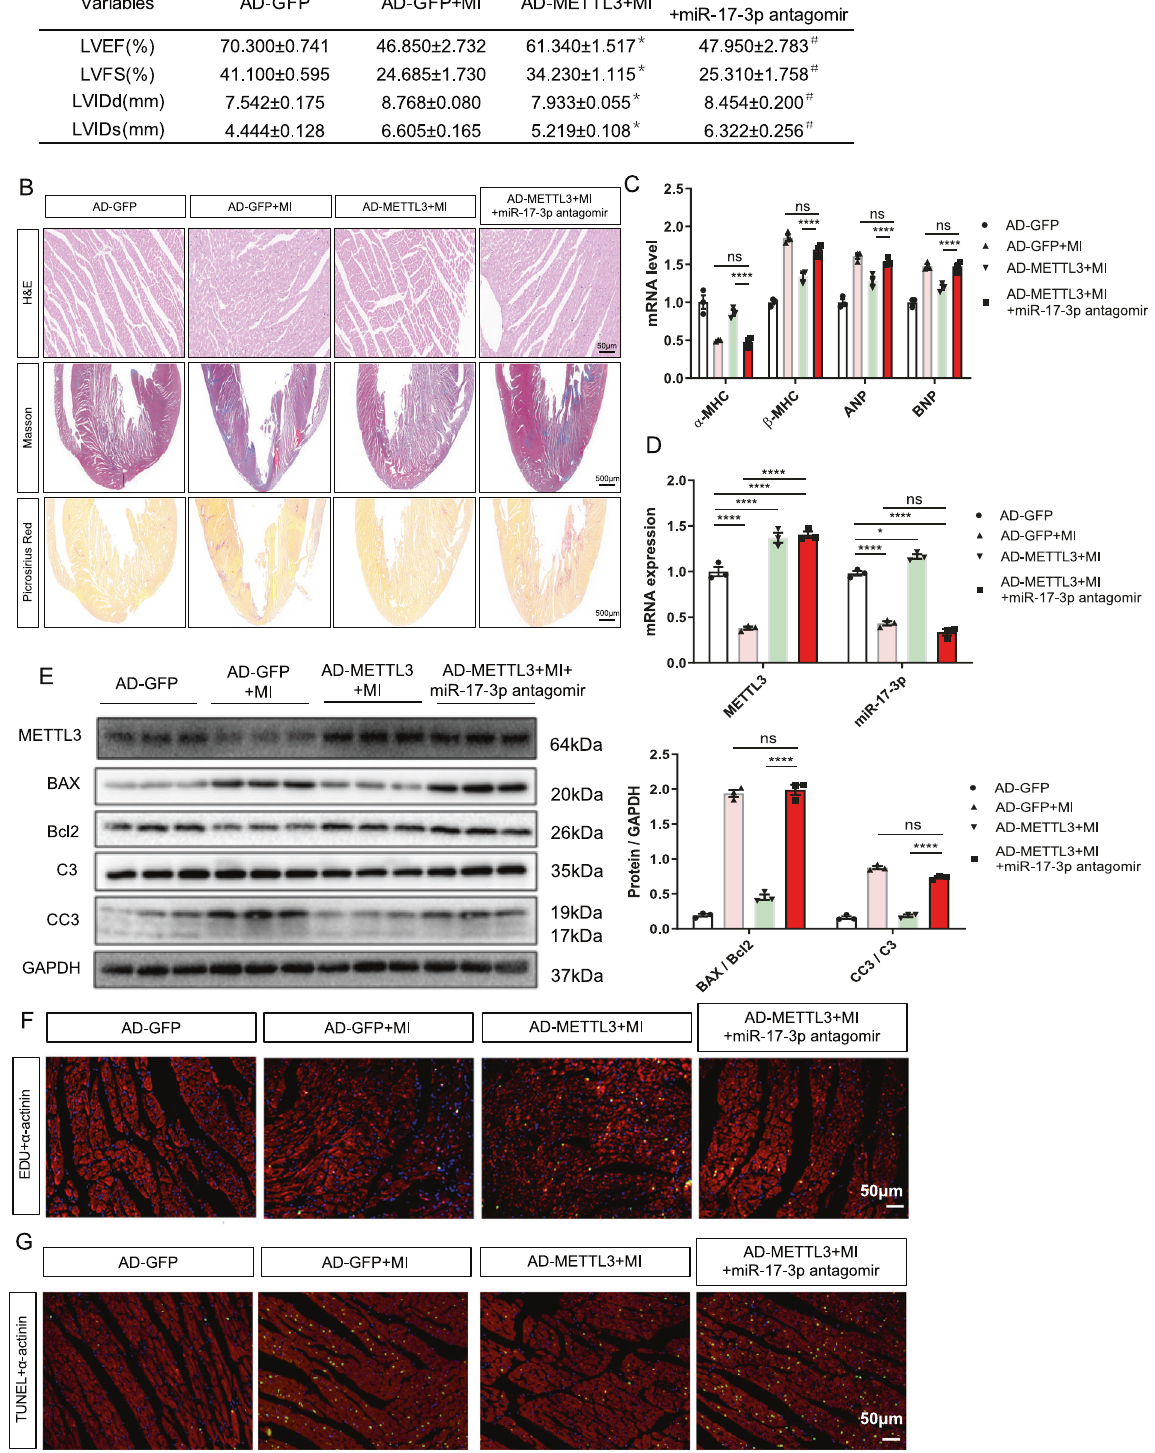
Fig. 6 miR-17-3p antagomir blocked the protective effects of METTL3 in myocardial infarction (MI)-induced rats. A Echocardiographic data of left ventricular function, n = 5. B Representative images of non-infarcted left ventricular myocardium sections stained with hematoxylin-eosin (HE; Scale bar, 500 μ m), Masson and picrosirius red (Scale bar, 50 μ m). C mRNA expression of α -MHC, β -MHC, ANP, and BNP in rats from indicated groups, n = 5. D mRNA expression of METTL3 and miR-17-3p in non-infarcted left ventricular myocardium from different groups, n = 3. E Protein expression of METTL3, BAX, Bcl2, C3, and CC3 in non-infarcted left ventricular myocardium from indicated groups, n = 3. F , G Representative immuno fl uorescence images of non-infarcted left ventricular myocardium sections labeled with EDU ( F ) or TUNEL ( G ) ( α -actinin, green; EDU or TUNEL, red; DAPI, blue. Scale bars, 50 μ m). The results are expressed as the mean ±